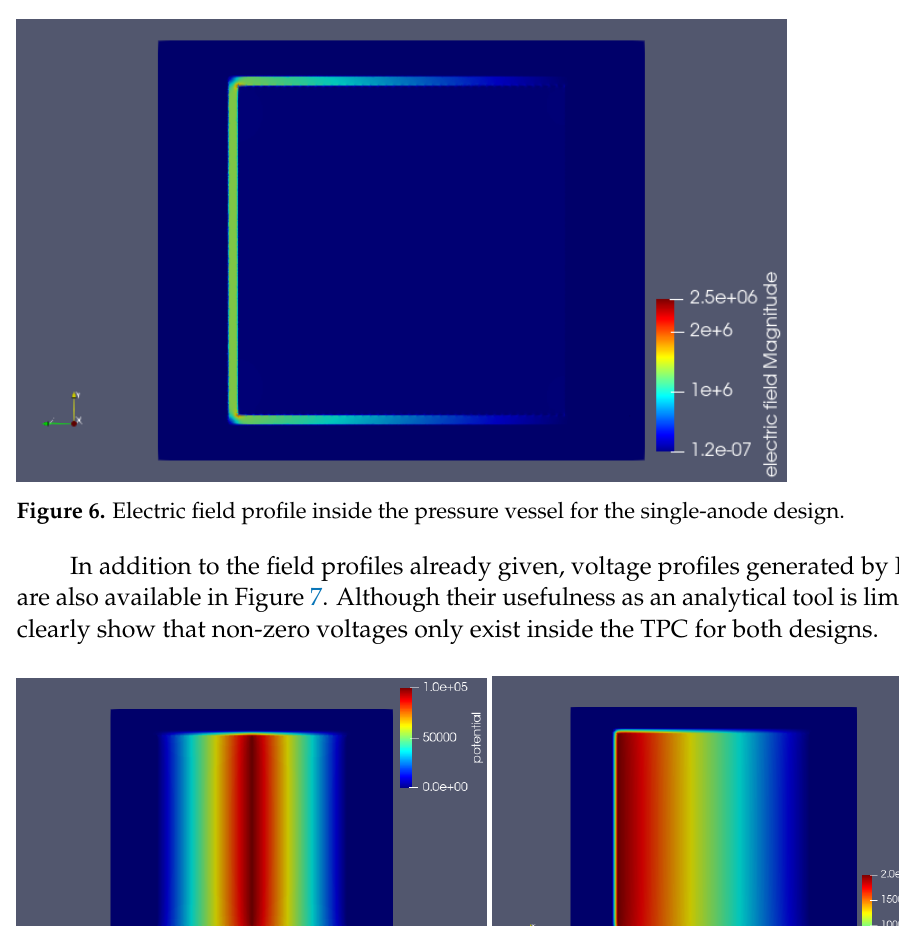
Figure 5. Electric field profile inside the pressure vessel for the dual-anode design.